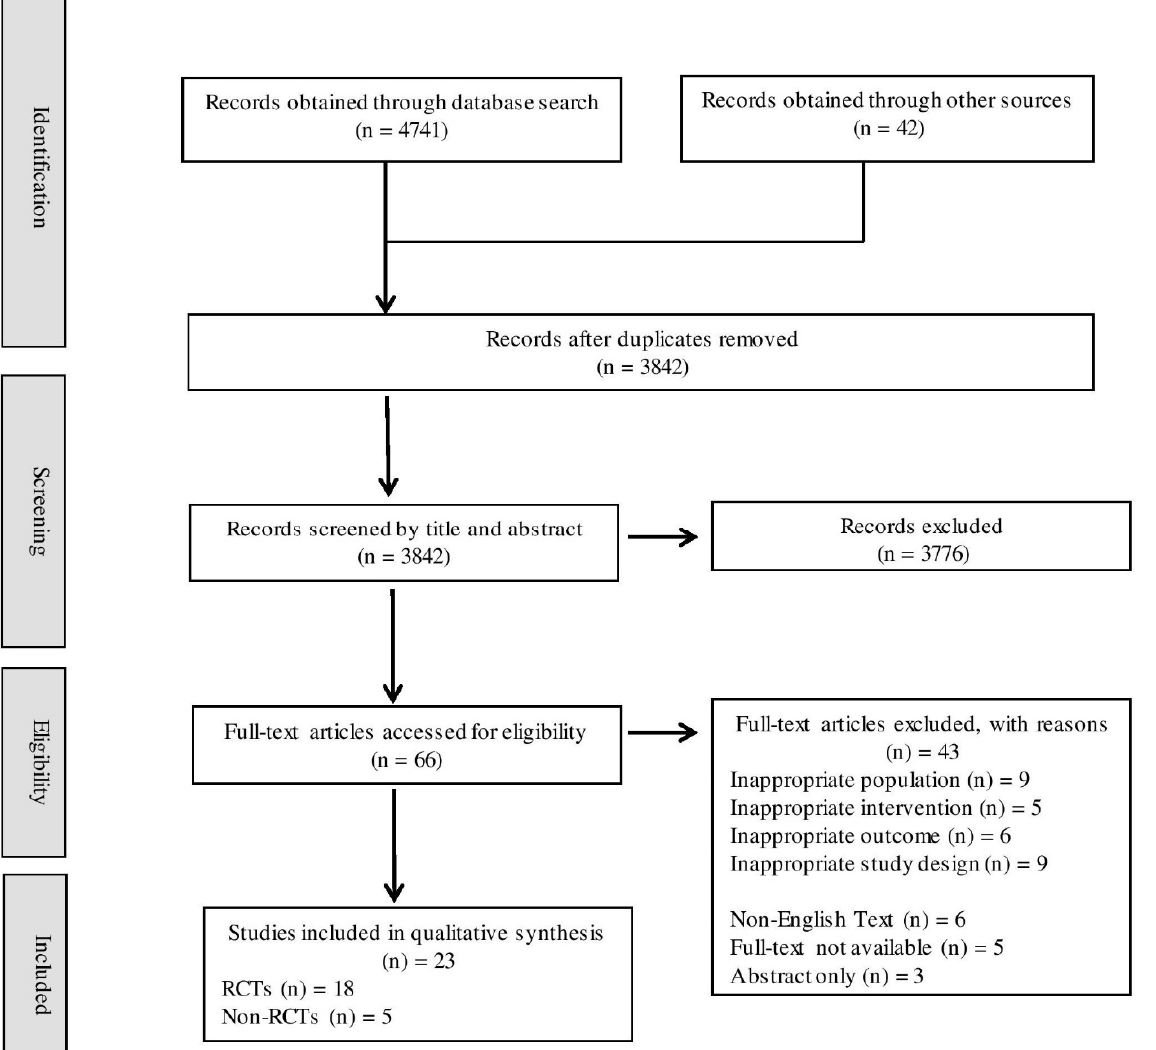
Figure 1. Flowchart of literature search and screening for selection of randomized and non-randomized controlled trials examining the effects ingredients found in functional foods, beverages, and supplements that claim to alleviate flight-related symptoms. Other sources included a hand search of reference lists of relevant systematic reviews as well as studies listed by products identified in scoping review.